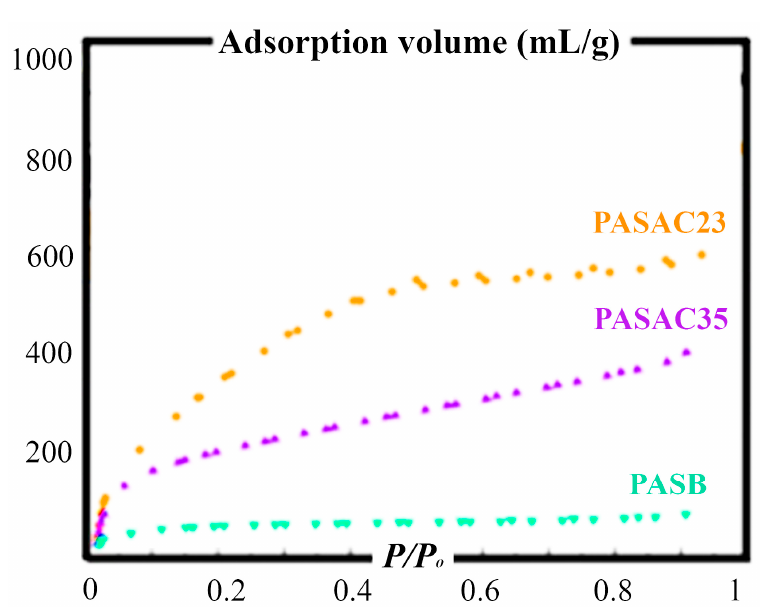
Figure 1. Adsorption/desorption isotherms of N 2 at 77 K of PASB, PASAC23 and PASAC35.